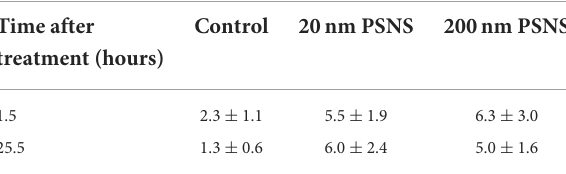
TABLE 1 Immunohistochemistry for cleaved caspase-3 (activated) in small intestine of mice after gavage of aqueous vehicle alone (Control), nominal 20nm, or 200nm